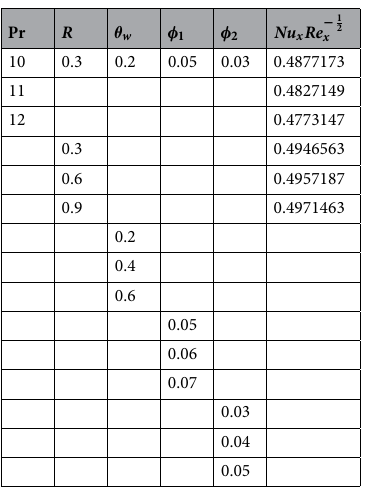
Table 3. Influence of dissimilar physical constraints over Nusselt number Nu x Re